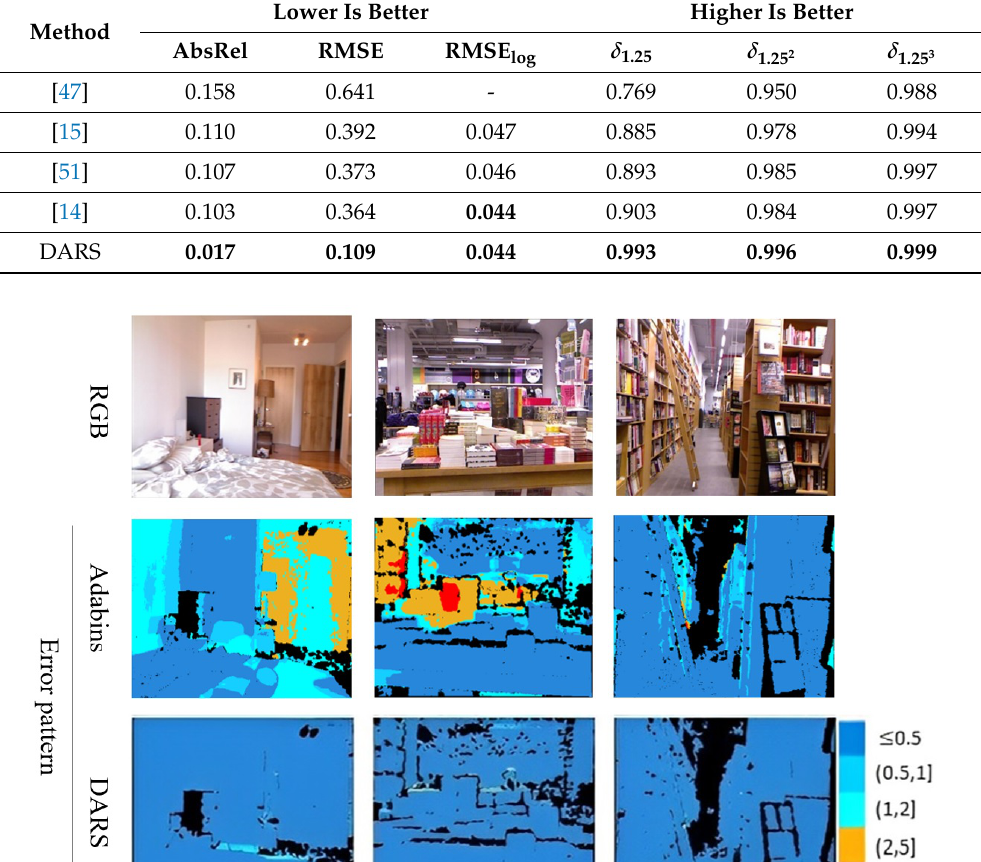
Table 3. Comparative study on NYUv2.The first part from above contains unsupervised methods while the second part is dedicated to supervised ones.